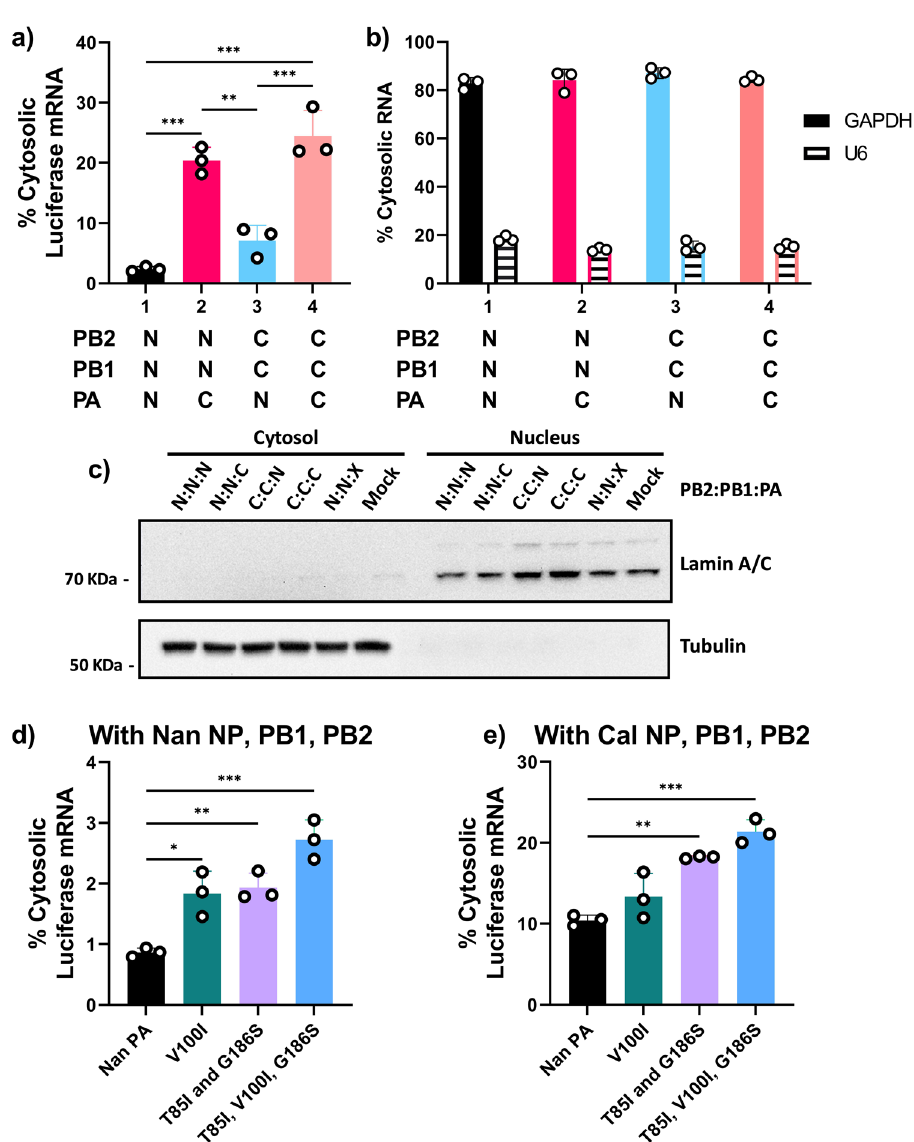
Fig. 5 PA mutations affect the cytosolic levels of viral mRNA. a – c 293 T cells were transfected with the indicated vRdRp subunits (N = Nan, C = Cal) along with Cal NP and pPolI-NP-luc. Cells were fractionated into nuclear and cytosolic fractions and RNAs were quantitated by qRT-PCR. a Percentages of cytosolic luciferase mRNA. b Percentages of cytosolic GAPDH mRNA and U6 snRNA. c Representative image of immunoblot analysis for tubulin (cytosolic marker) and lamin (nuclear marker) detected by speci fi c antibodies. X indicates no PA. d 293 T cells were transfected with Nan NP, PB1, PB2, pPolI-NP-luc and Nan PA with the indicated mutations. Cells were fractionated into nuclear and cytosolic fractions and RNAs were quantitated by qRT-PCR. e 293 T cells were transfected with Cal NP, PB1, PB2, pPolI-NP-luc and Nan PA with the indicated mutations. Cells were fractionated into nuclear and cytosolic fractions and RNAs were quantitated by qRT-PCR. Error bars show the means plus/minus standard deviations ( n = 3 biological replicates). One- way ANOVA followed by Tukey ’ s multiple comparison test (* P < 0.05, ** P < 0.01, *** P <